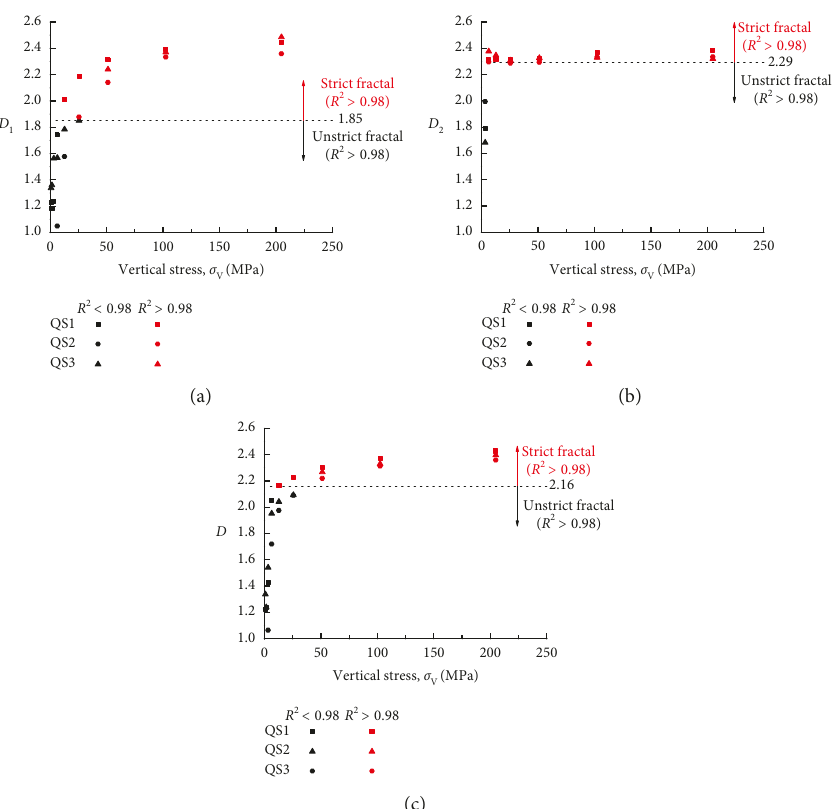
Figure 7: Relationship between vertical stress σ V and fractal dimensions (a) D 1 , (b) D 2 , and (c) D